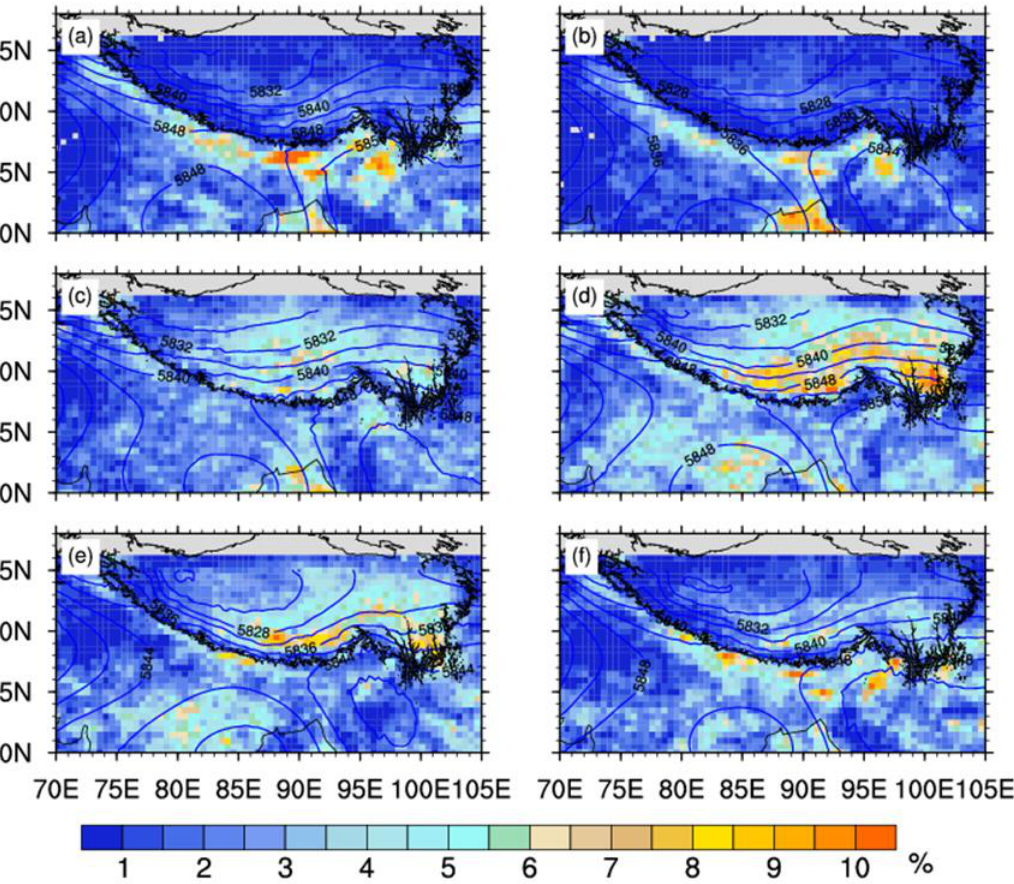
Figure 8. The distribution of precipitation frequency for DCP in ( a ) early morning, ( b ) forenoon, ( c ) noon, ( d ) afternoon, ( e ) evening, and ( f ) midnight in summer over the QTP and its southern regions calculated from observations of TRMM PR from 1998 to 2012. The overlapped contours are geopotential height at 500 hPa in each time period. Note: This is the same as in Figure 6.